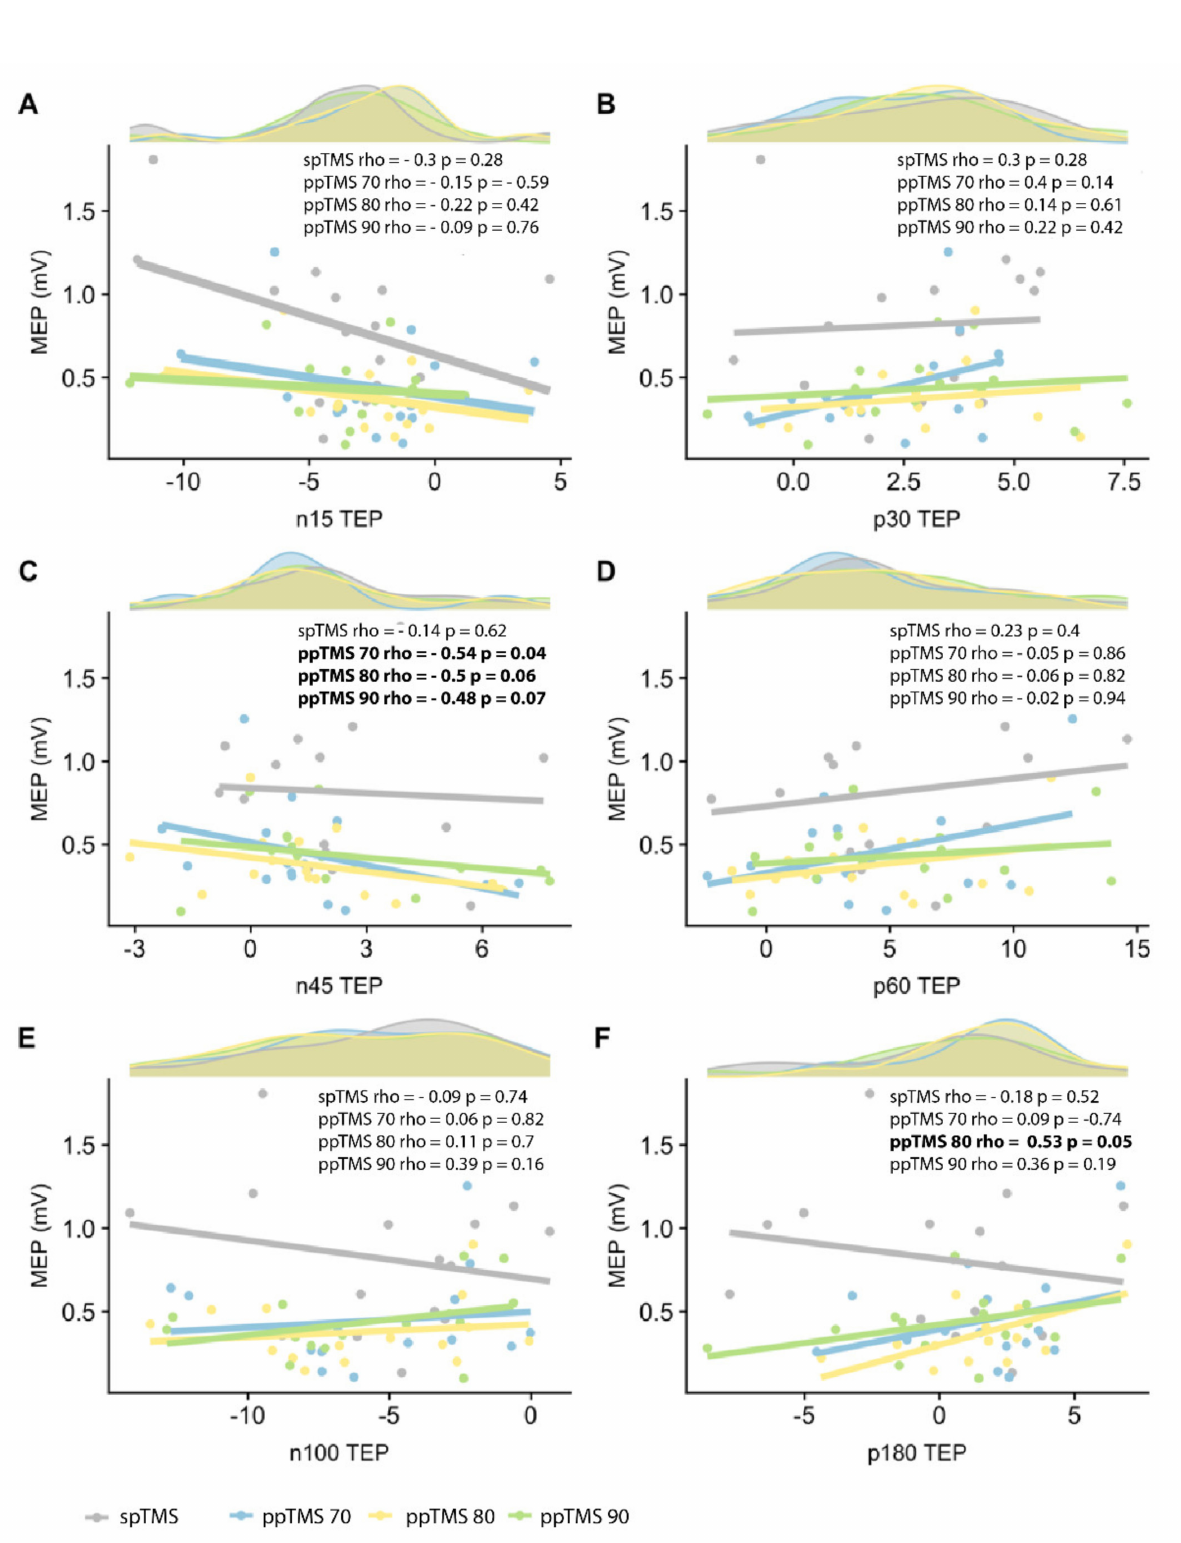
Figure 2. Spearman rank correlations between MEP and TEP peaks for single pulse, ppTMS 70, 80, 90. Each plot ( A – F ) shows Spearman rank correlations between the MEP amplitude and TEP peak amplitude (N15, P30, N45, P60, N100 and P180), for spTMS and each ppTMS condition. Above each plot is the distribution of each peak per condition. Time-frequency characteristics of ppTMS TEPs. Bold text in the figure represents interactions reaching statistical significance at a level of